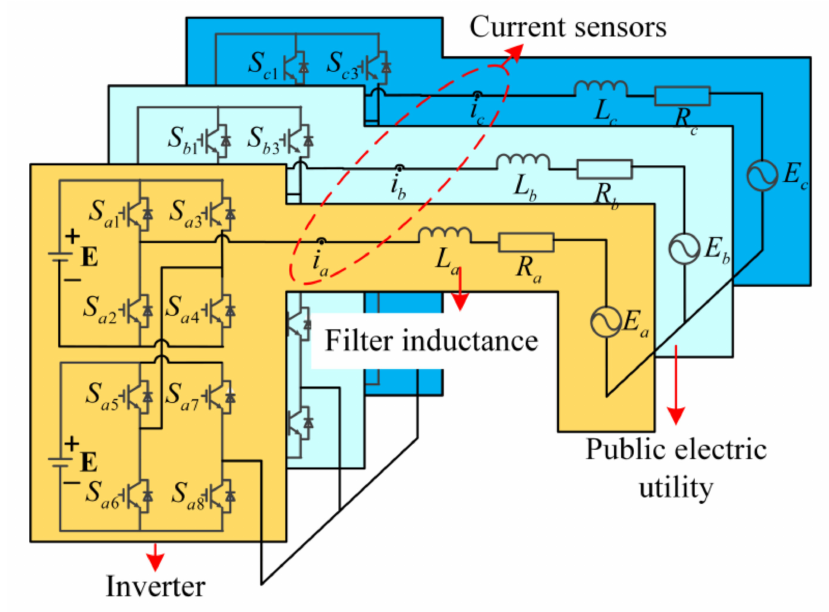
Figure 1. Block diagram of three-phase grid-connected